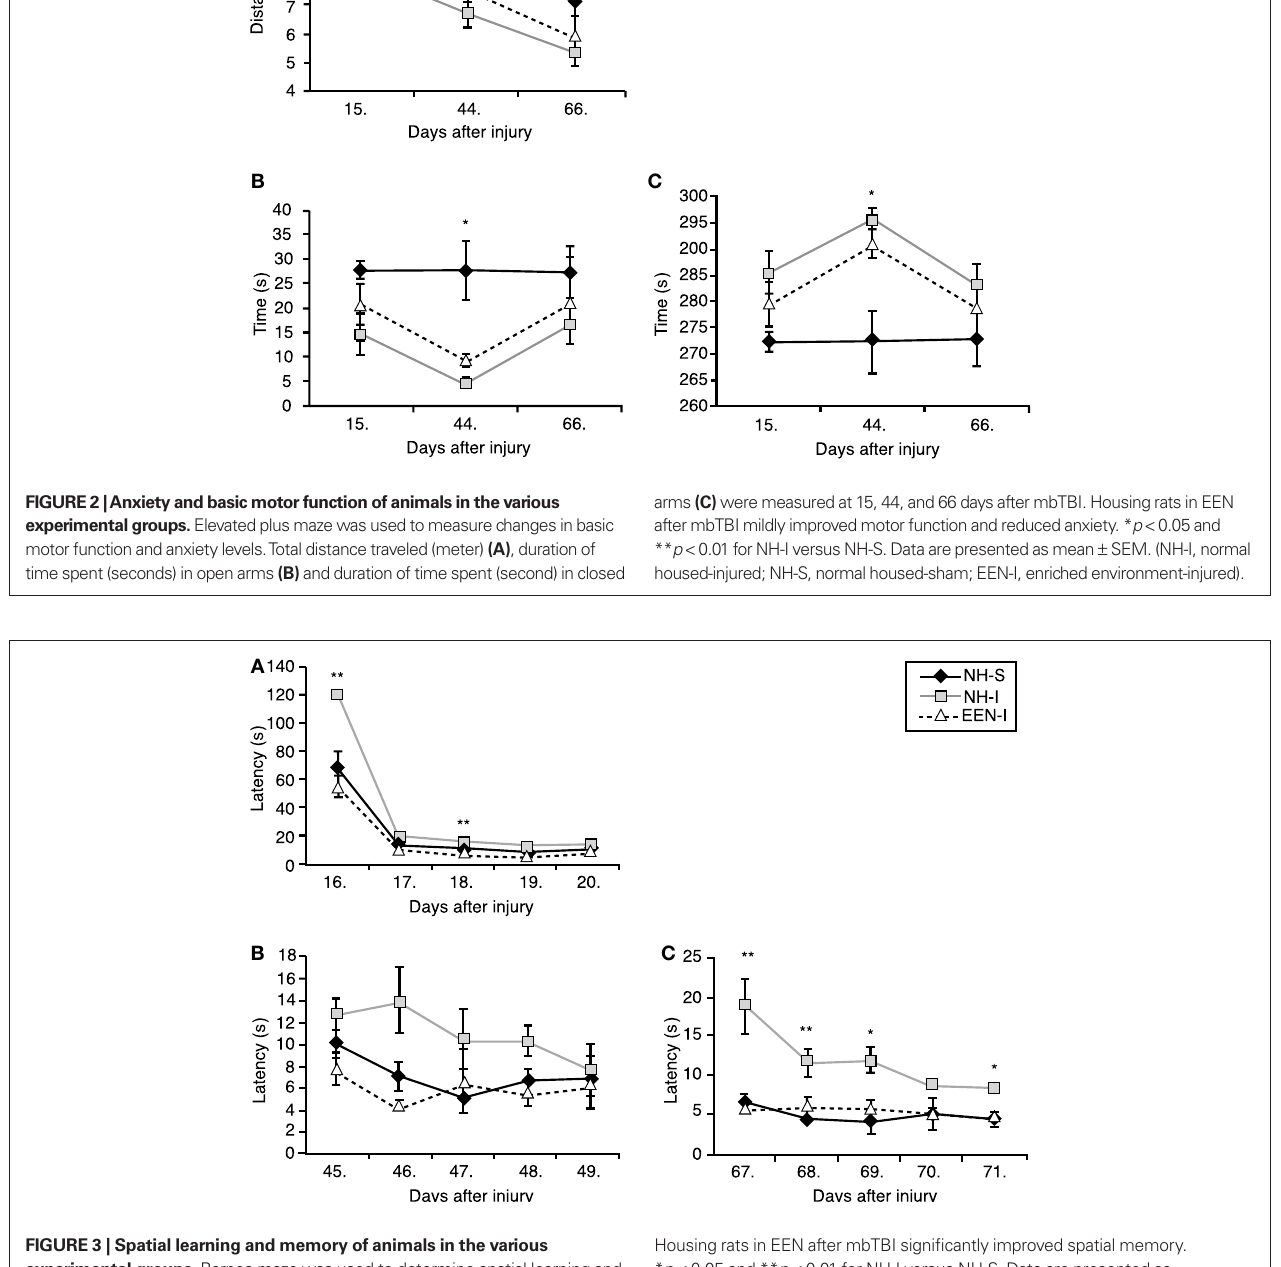
Figure 3 | Spatial learning and memory of animals in the various experimental groups. Barnes maze was used to determine spatial learning and memory performance. Latency times (second) to find the escape box were measured on days 16–20 (A) , days 45–49 (B) , and days 67–71 (C) after mbTBI.